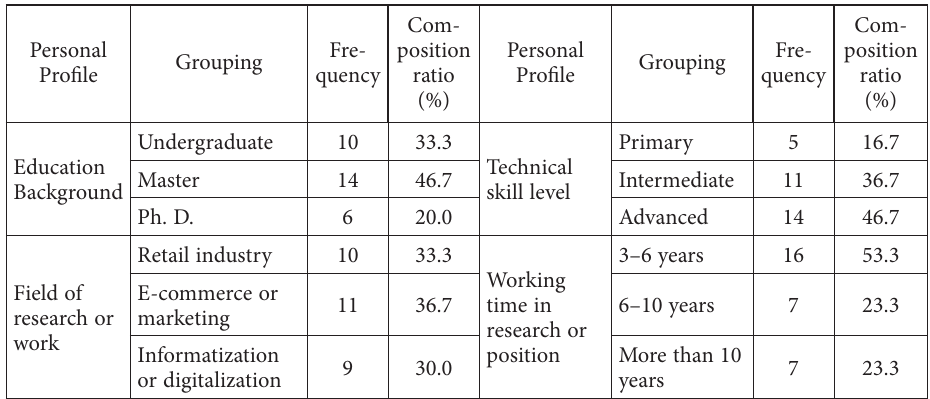
Table 6. Basic information of